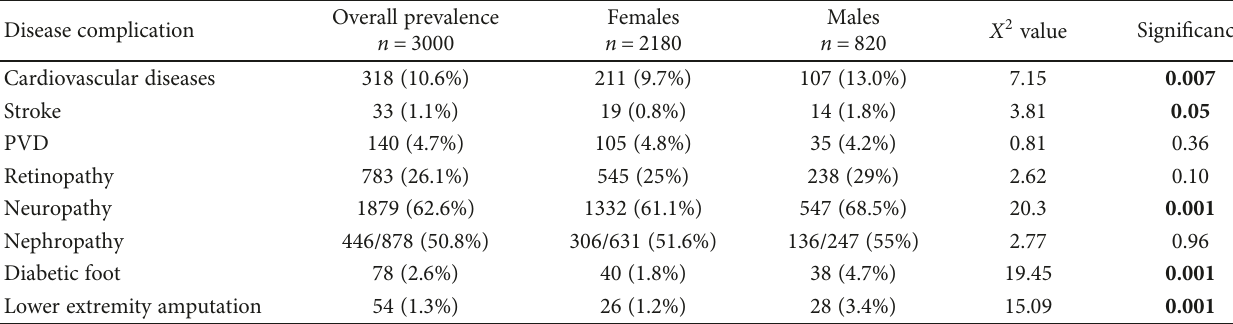
Table 2: Vascular complications by